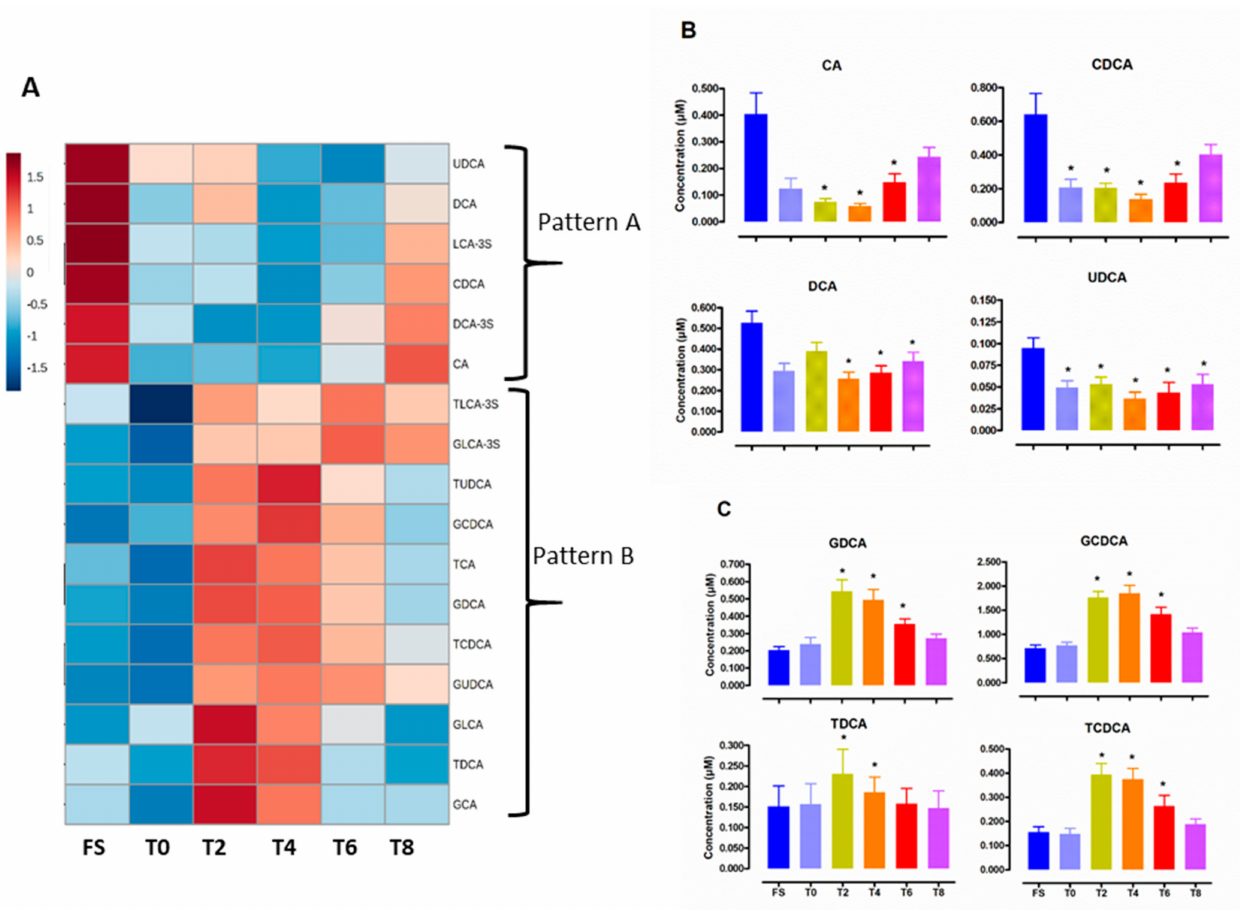
Figure 2. Postprandial levels of individual BA species during postprandial exploration: FS for overnight fasting samples, T0, T2, T4, T6, T8 for before and 2 h, 4 h, 6 h and 8 h after consumption of a hypercaloric high fat test meal. ( A ) Hierarchical cluster analysis of plasma concentrations of BA species according to postprandial time course: Mean circulating levels of individual species of unconjugated BAs ( B ) and of conjugated BAs ( C ) during postprandial exploration. Values are mean ± SEM. * p < 0.05 versus overnight fasting